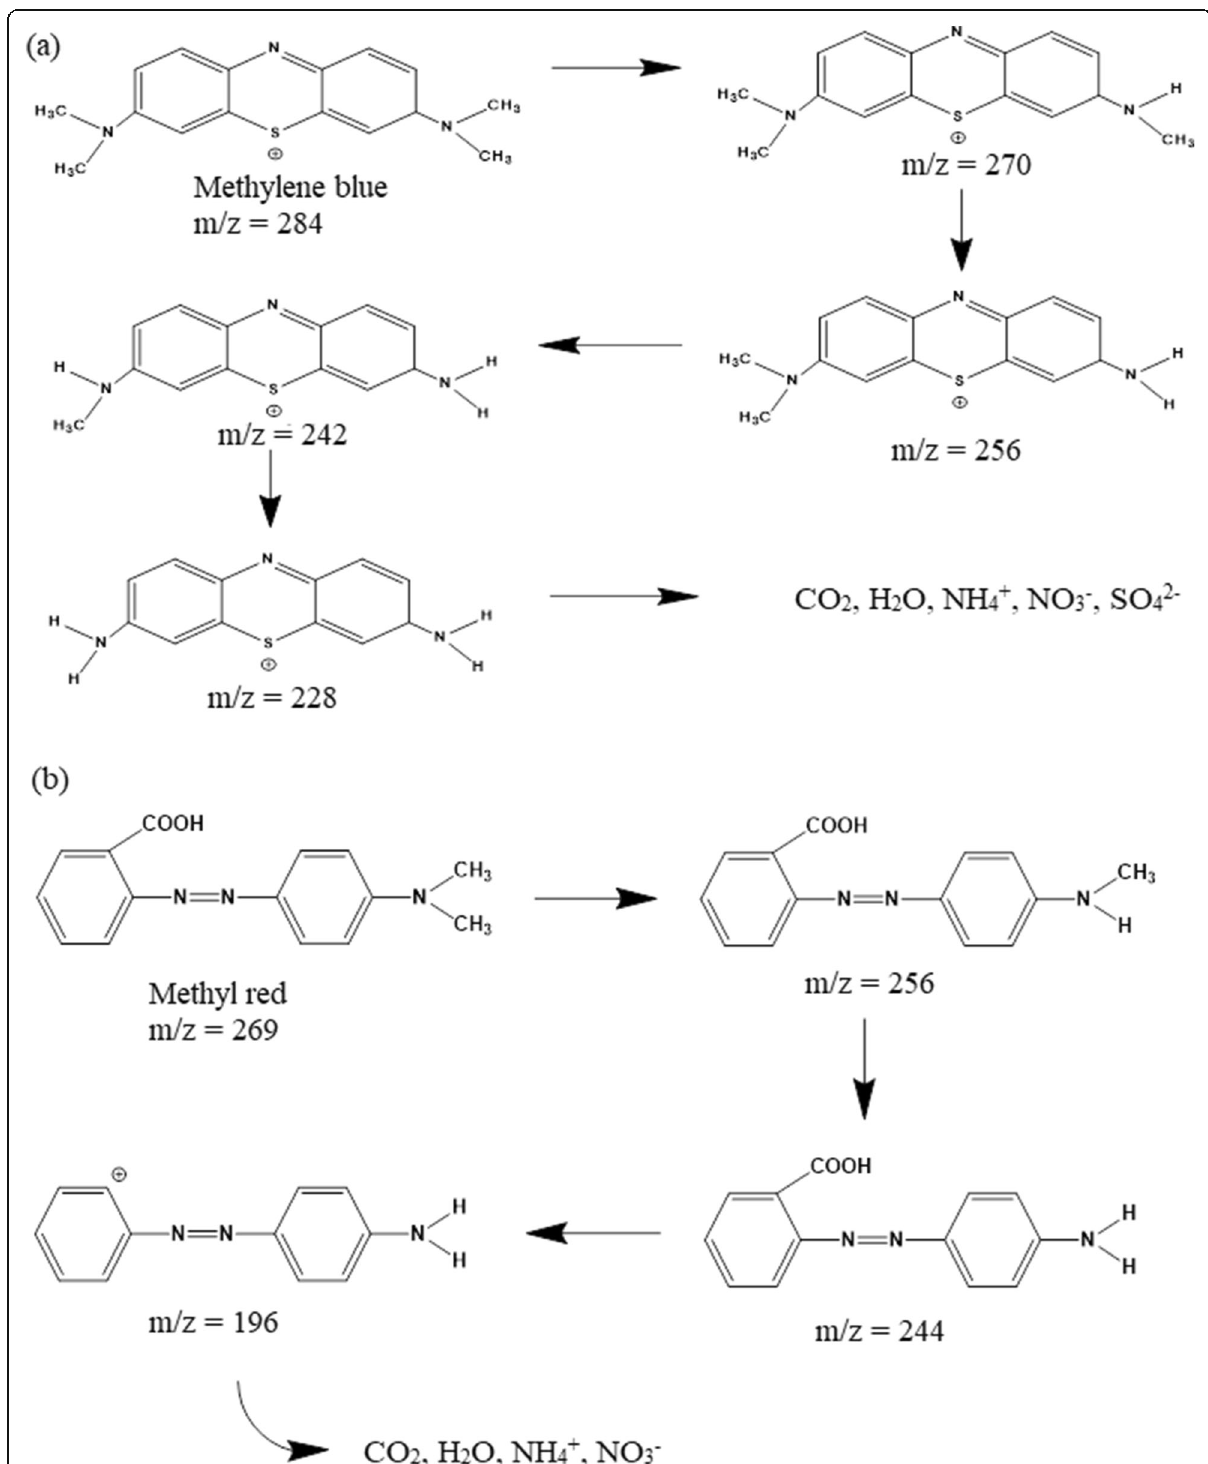
Fig. 10 ( a ) MS data suggests a methylene blue (MB) dye degradation mechanism by CuO nanoparticles ( b ) MS data suggests a methyl red (MR) dye degradation mechanism by CuO